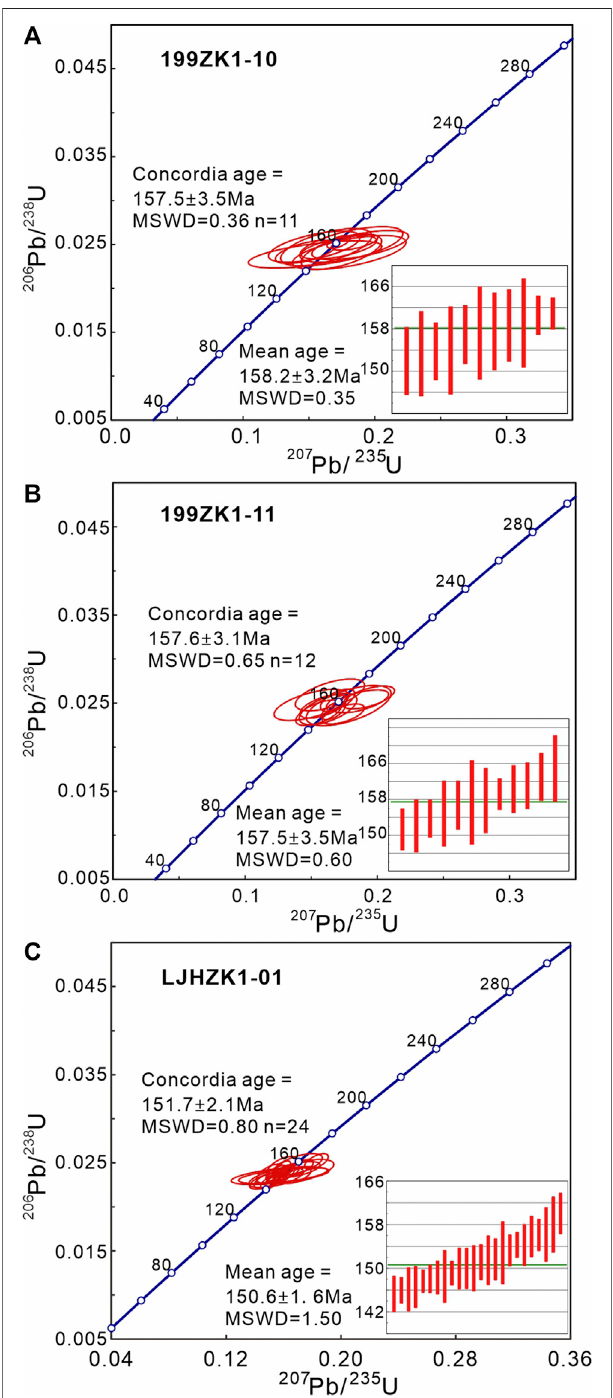
FIGURE 5 | LA-ICP-MS zircon U – Pb concordia diagrams for the Linglong (A – B) and Luanjiahe (C) granites.